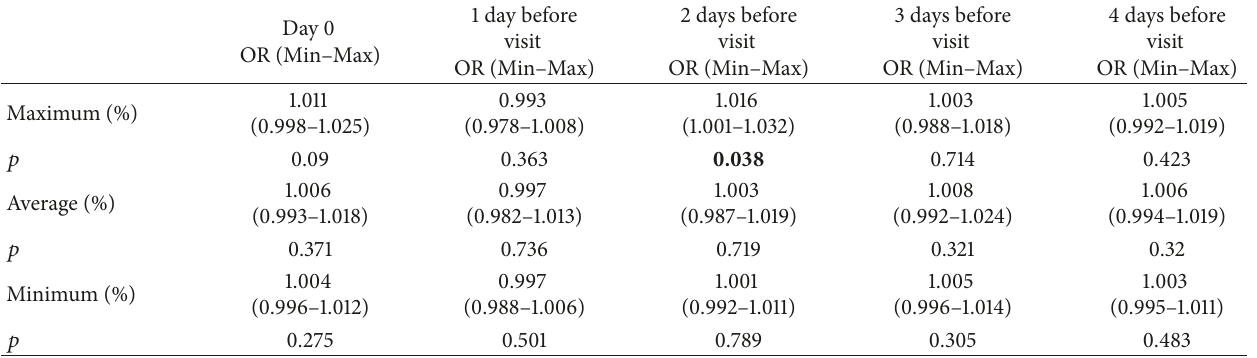
Table 7: Humidity for 4 days before visit due to pneumonia.